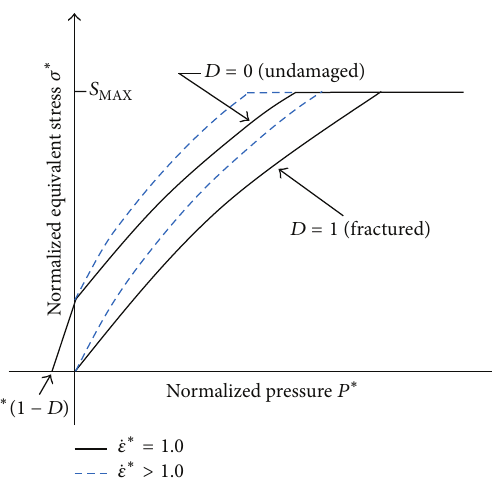
Figure 3: JHC model for concrete